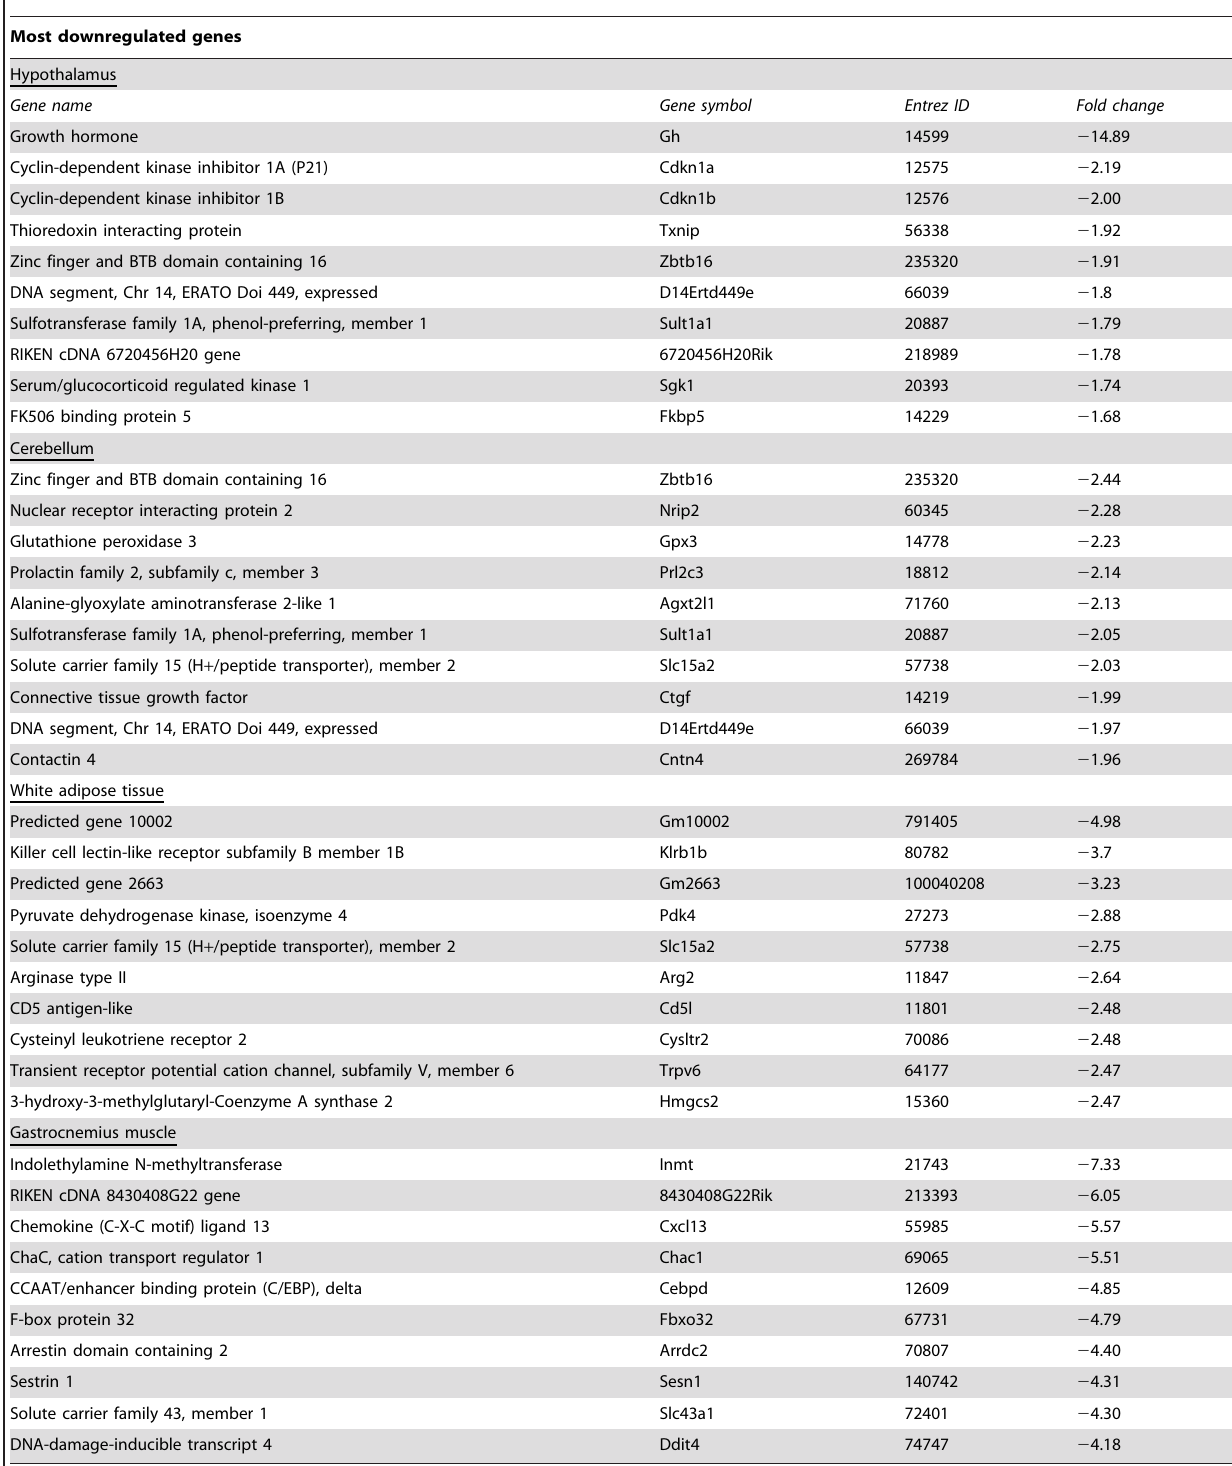
Table 2. Top 10 genes that showed the highest amount of downregulation in FTO-4 mice per tissue.